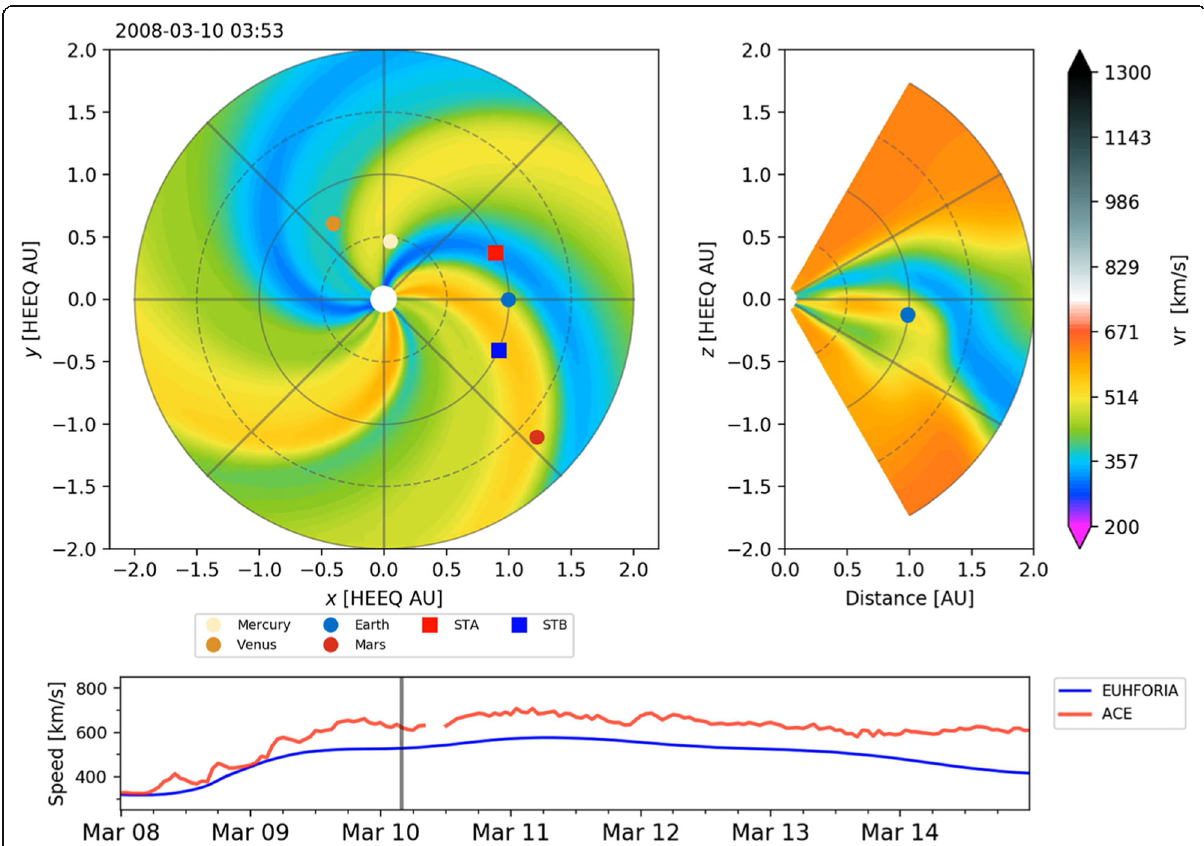
Fig. 34 Snapshot of the background solar-wind radial speed modeled by EUHFORIA. The top-left panel shows the MHD solution in the heliographic equatorial plane, and the right panel shows the meridional plane cut that includes the Earth (blue circle). The lower panel shows comparison of the modeled and observed solar wind by EUHFORIA and ACE, respectively. Taken from Hinterreiter et al.